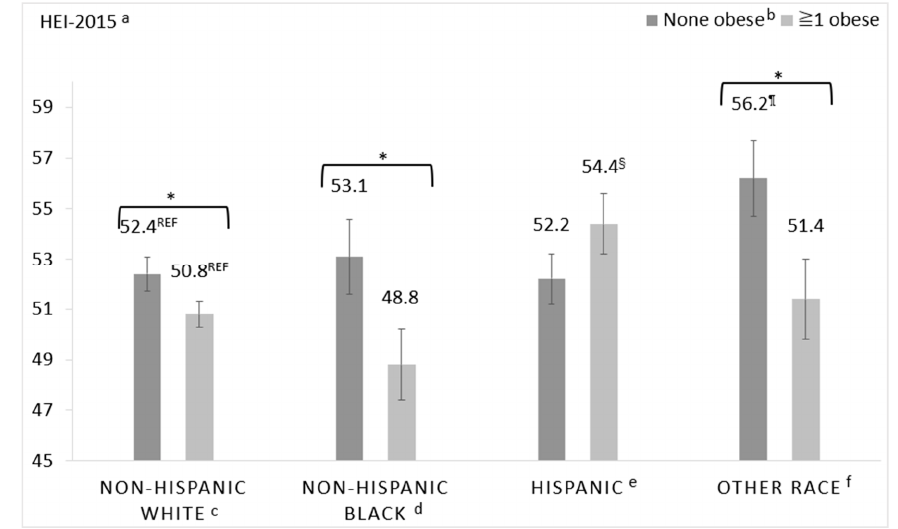
Figure 5. Multivariable-adjusted least square means of total HEI-2015 score of household grocery Survey 2012–2013, ( n = 3954), stratified by race / ethnicity and weight status of household members (none obese vs. ≥ 1 obese). a Healthy Eating Index 2015, b obesity defined as body mass index (BMI) ≥ 30 kg / m 2 , c non-Hispanic White, none obese, n = 1232; non-Hispanic White, ≥ 1 obese, n = 1161, d non-Hispanic Black, none obese, n = 164; non-Hispanic Black, ≥ 1 obese, n = 298, e Hispanic, non-obese, n = 292; Hispanic, ≥ 1 obese, n = 507, f Other race, none obese, n = 187; Other race, ≥ 1 obese, n = 113. Scores under asterisked (*) brackets indicate significant within race / ethnicity group post hoc di ff erences; superscripted symbols indicate significant between-groups comparison using NHW as the reference group—i.e., ¶ indicates significantly di ff erent from NHW, none obese and § indicates significantly di ff erent from NHW, ≥ 1